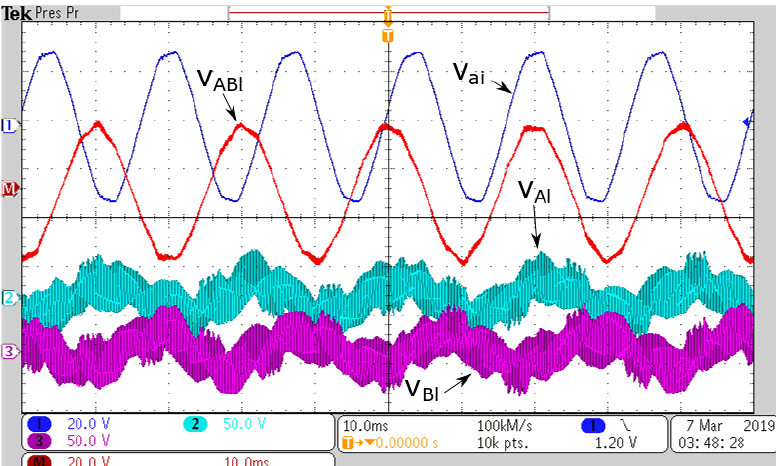
Figure 12. MC input-output